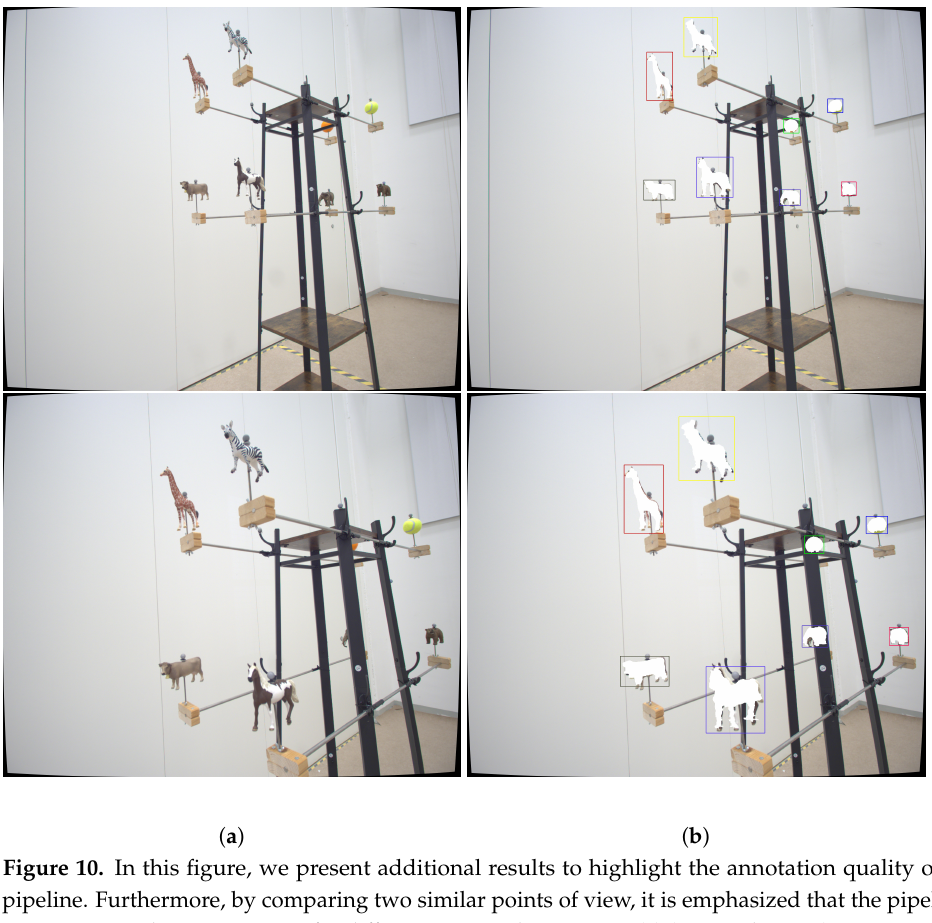
Figure 10. In this figure, we present additional results to highlight the annotation quality of our pipeline. Furthermore, by comparing two similar points of view, it is emphasized that the pipeline’s annotation quality is consistent for different camera distances. In ( a ) (Original Image), we present the original image and in ( b ) (Annotation Result) the annotation results. Best viewed as PDF and in